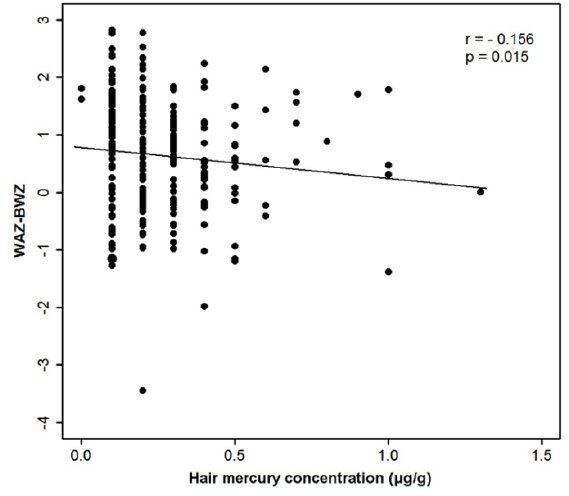
Figure 2. Correlation between hair mercury content and